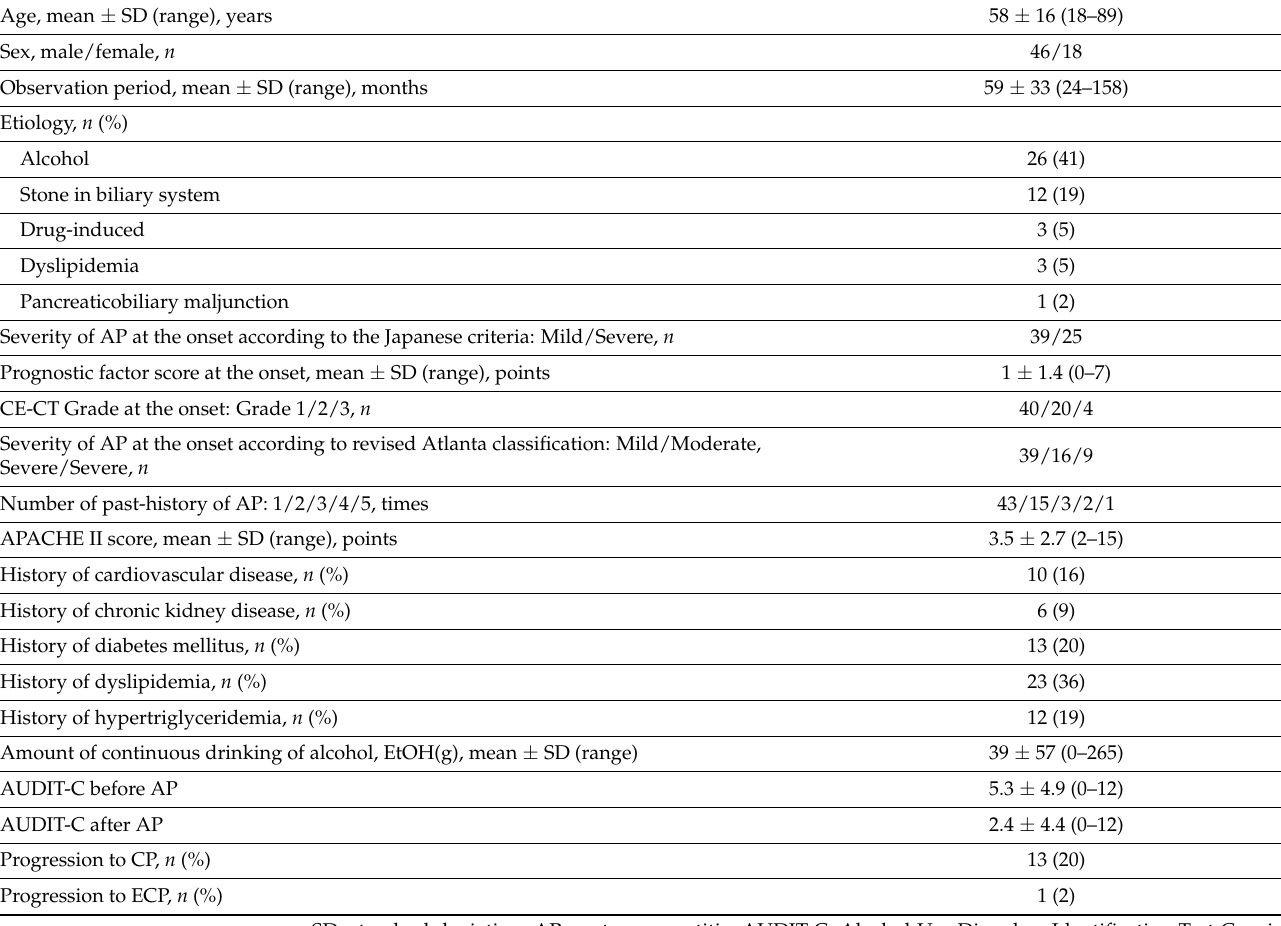
Table 1. Overall patient